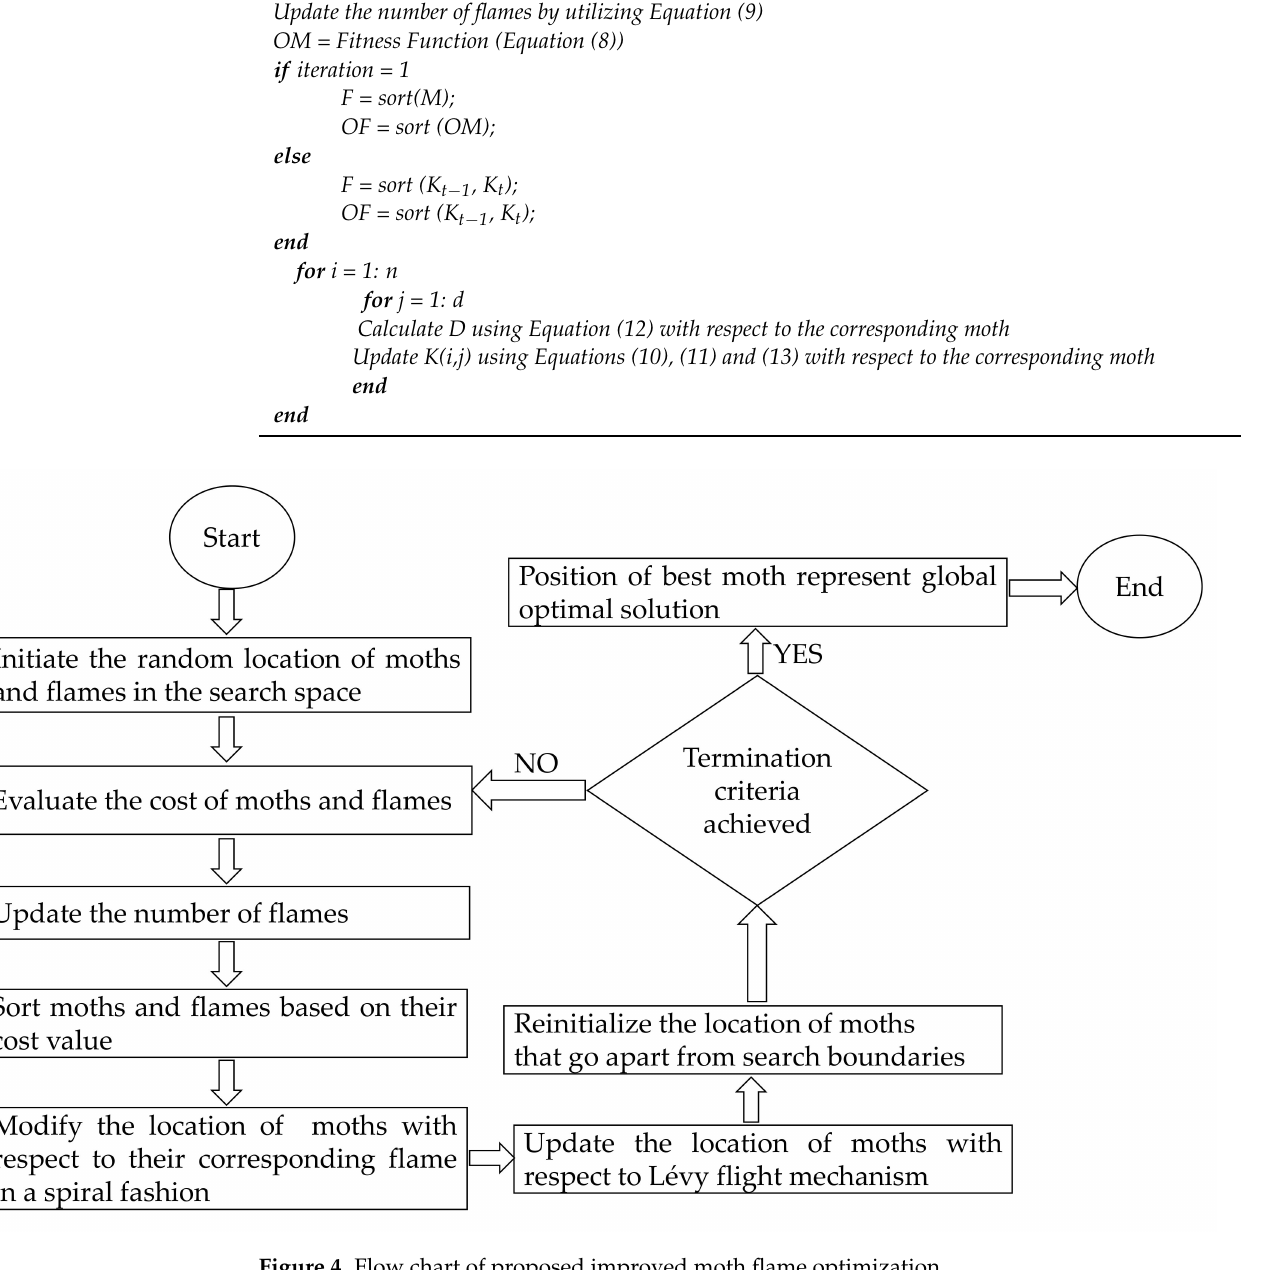
Figure 4. Flow chart of proposed improved moth flame